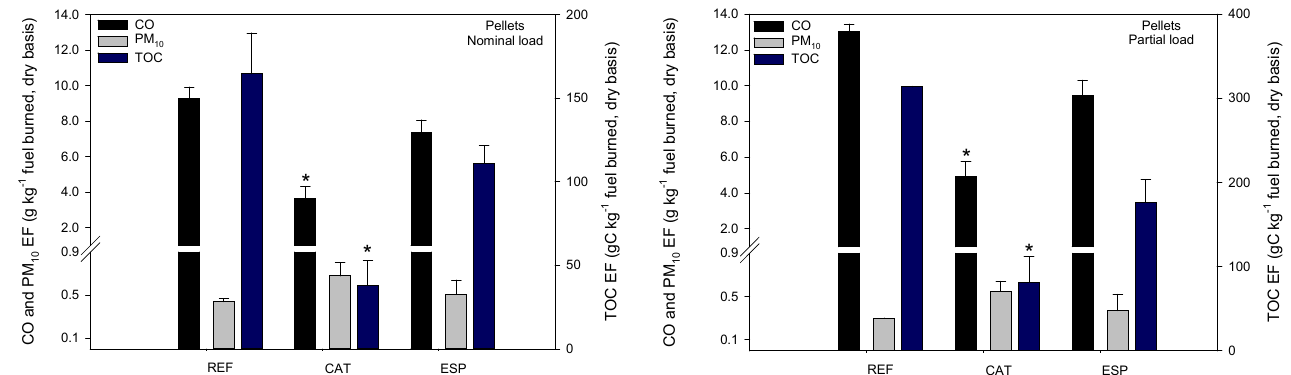
Figure 4. CO, TOC, and PM 10 emission factors from wood pellet combustion at nominal and partial loads with or without catalytic converter (CAT) and electrostatic precipitator (ESP). Asterisks indicate a statistically significant difference compared to the reference condition (REF) ( p < 0.05; Kruskal–Wallis test).